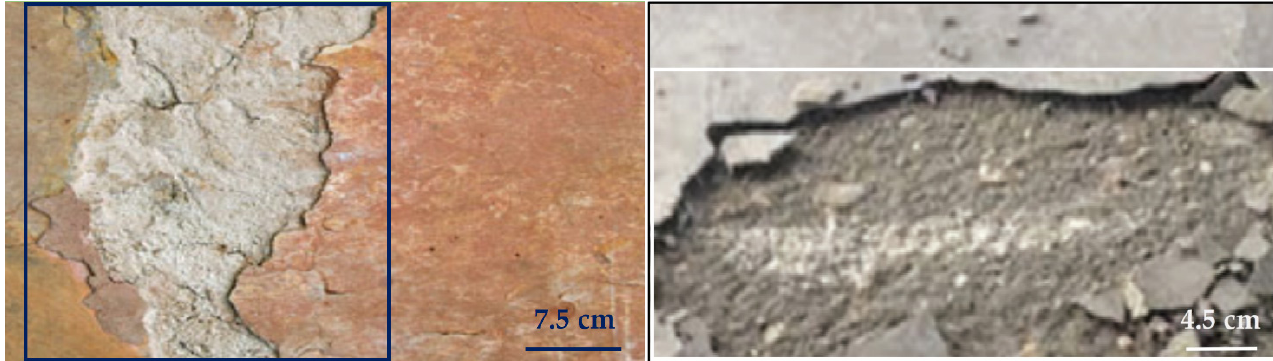
Figure 2. Sample images of concrete with delamination defects.